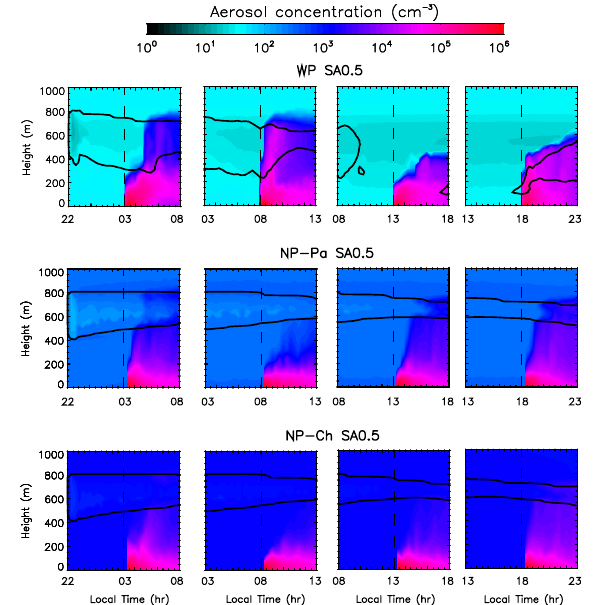
Fig. 8. Time series of domain maximum aerosol concentrations (cm − 3 ) for the WP, NP-Pa and NP-Ch cases (all SA0.5 aerosol in- jection rate). Plots include 5 h prior to injection and 5 h subsequent to injection, with aerosol injection start time being indicated by the vertical dashed